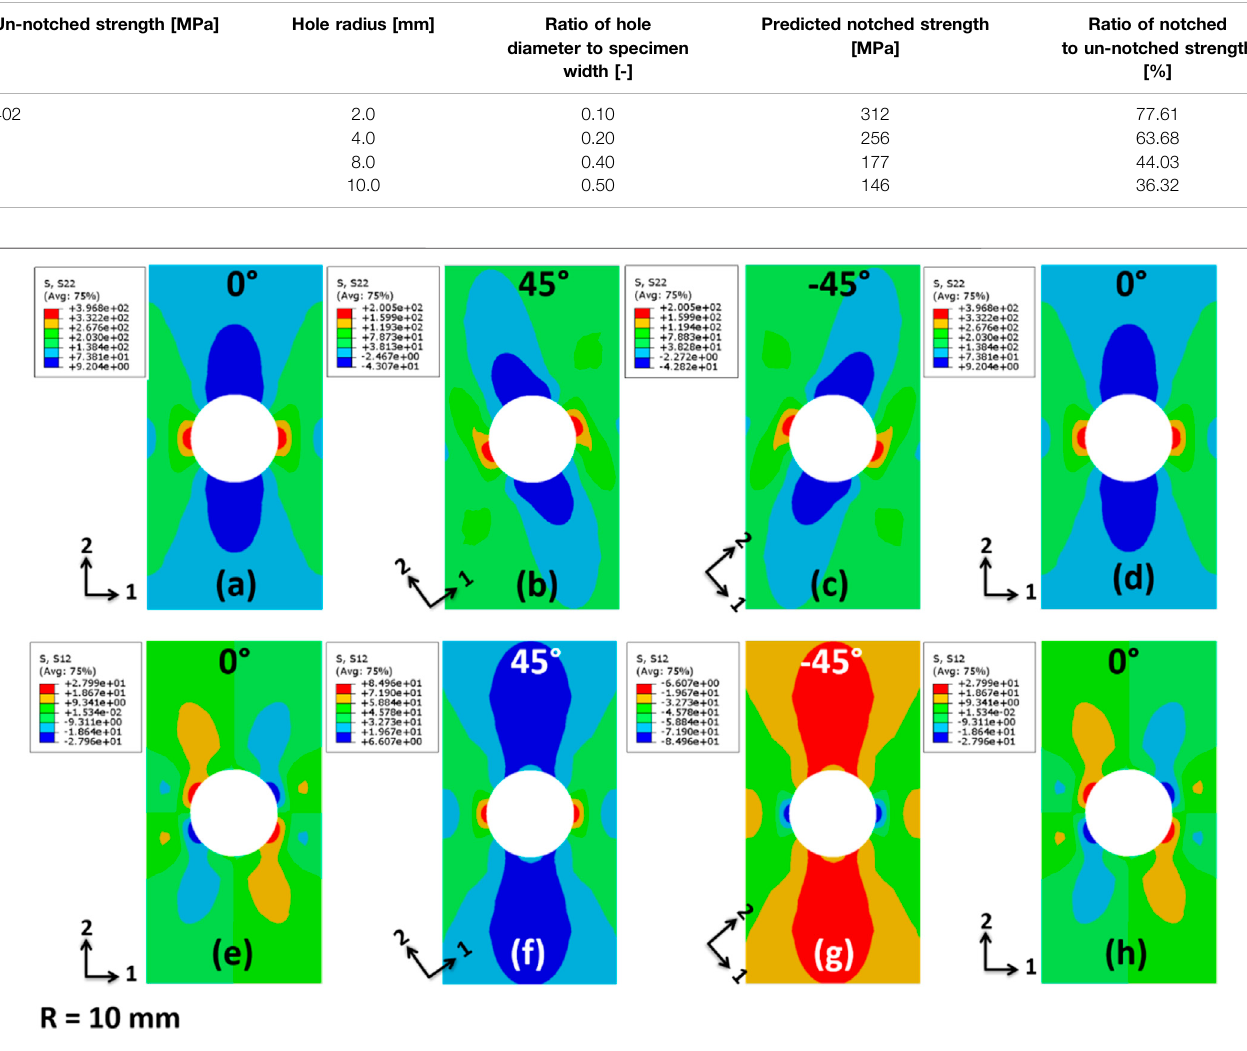
FIGURE9| Stresscontoursof[0,45, – 45,0]laminatesimmediatelybeforedamageonset(tensilestress σ (cid:1) 96 MPa): (A – D) plotoftensilestressesalongthe fi ber direction; (E – H) in-plane shear stress.